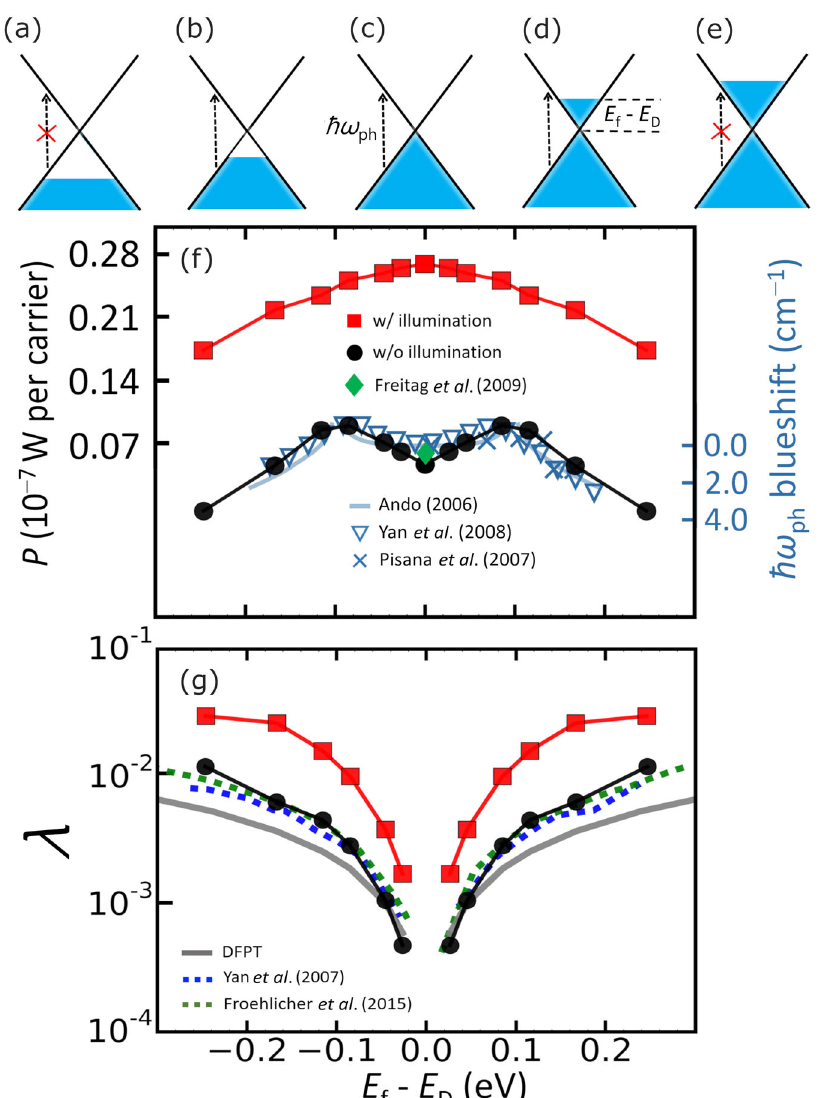
Fig. 2 The energy transport and EPC strength λ in graphene. a – e Schematics showing vertical interband transitions in the Dirac cone with different doping concentrations (represented by ±( E f − E D ) where E f is the Fermi level and E D is the energy level of Dirac point). Regions with blue shades are fi lled with electrons. The black arrows indicate the e-h excitations. f The energy transport rate P as a function of E f − E D with and without laser illumination. The green diamond marks the experimental data of P from Freitag et al. 10 . The blue symbols and lines show anomalous phonon softening measured by Raman spectroscopy in ref. 36 , ref. 74 and ref. 81 . g The EPC strength λ as a function of E f − E D with and without laser illumination. The dashed blue and green lines represent experimental results from ref. 75 and ref. 82